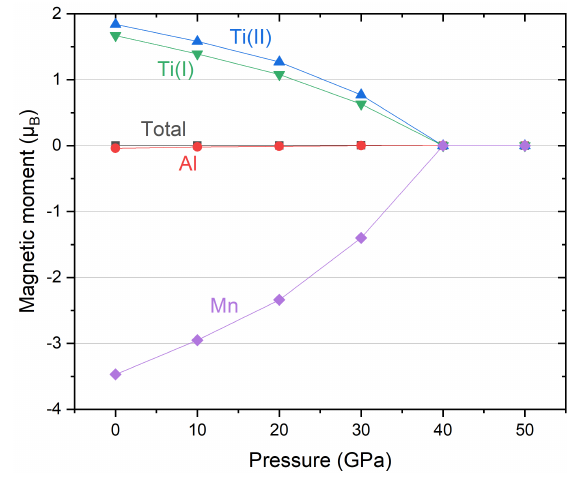
Figure 5. Total and atom-resolved magnetic moments of Ti 2 MnAl compound under different pressure. Atomic site is referred as the crystal structure in Figure 1.